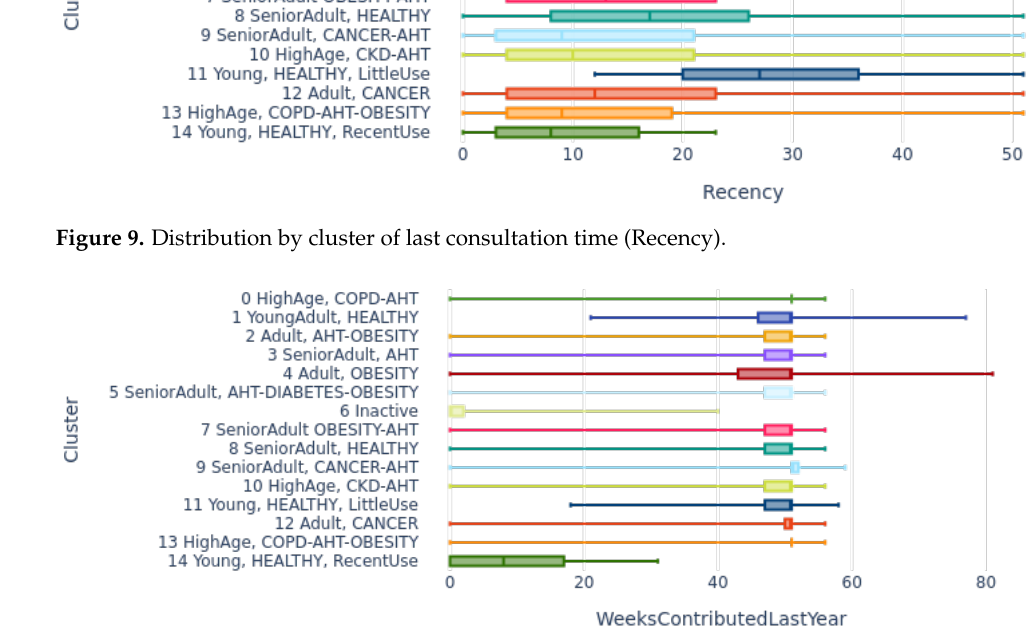
Figure 9. Distribution by cluster of last consultation time (Recency).